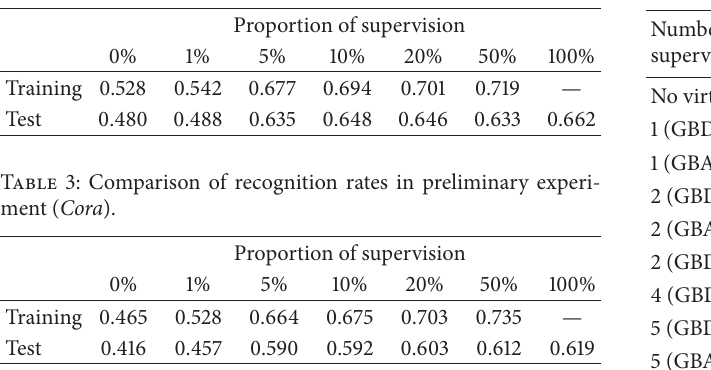
Table 2: Comparison of recognition rates in preliminary experi- ment ( CiteSeer ).